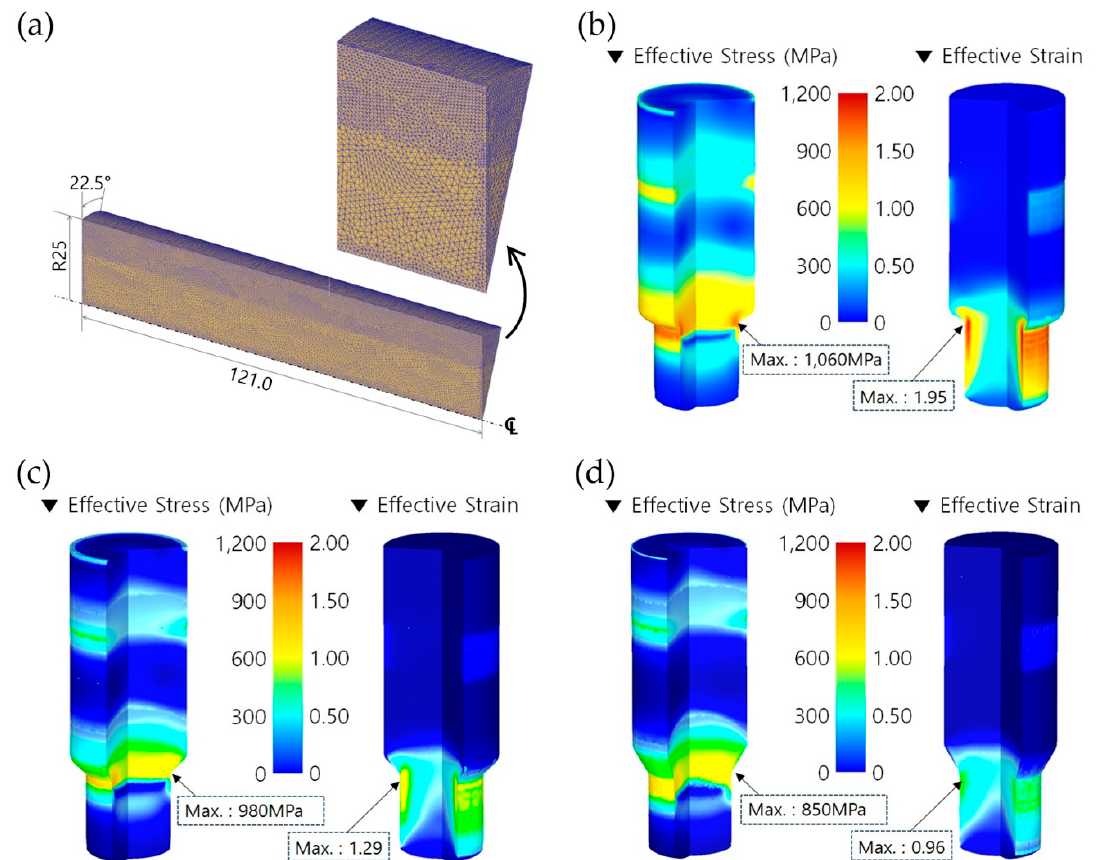
Figure 7. ( a ) Initial mesh structure with about 260,000 tetrahedral elements (unit: mm); ( b ) effective stress and strain distribution with a θ 1 of 30°; ( c ) effective stress and strain distribution with a θ 1 of 45°; ( d ) effective stress and strain distribution with a θ 1 of 60°.